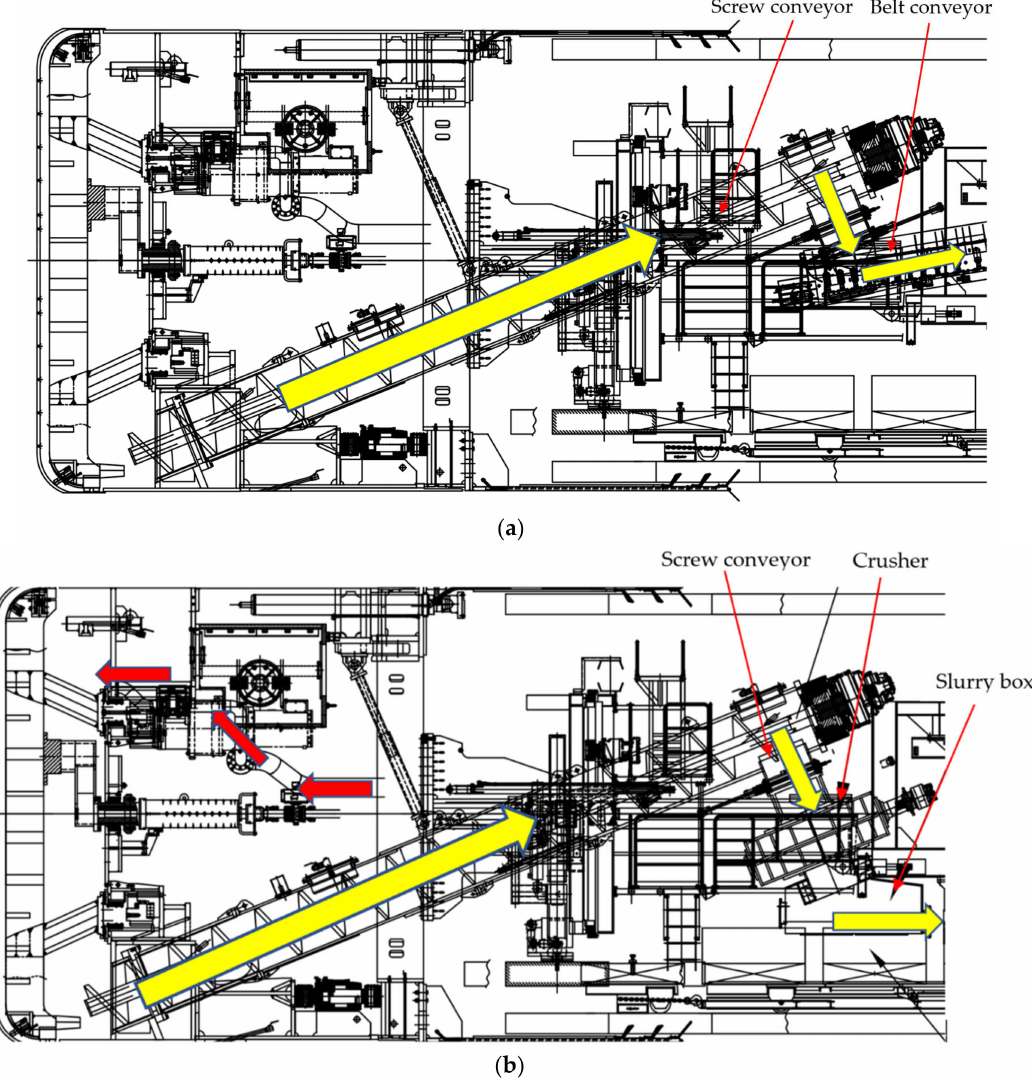
Figure 2. Schematic diagram of the shield tunneling mode; ( a ) EPB mode; ( b ) Slurry